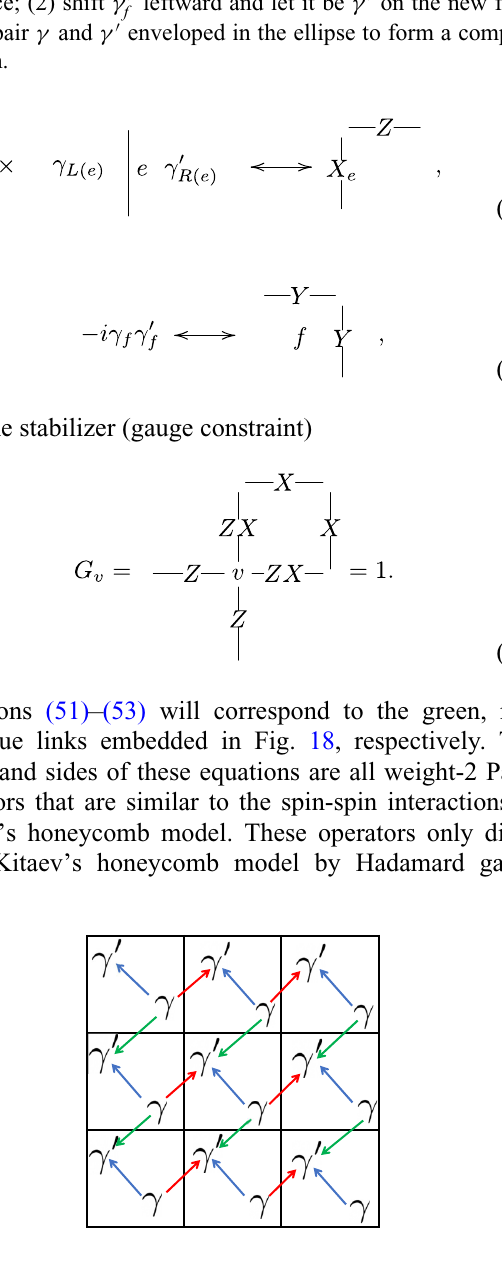
FIG. 18. The embedding of the honeycomb lattice into the square lattice. The red, blue, and green links correspond to the x , y , and z types in Kitaev’s honeycomb model.